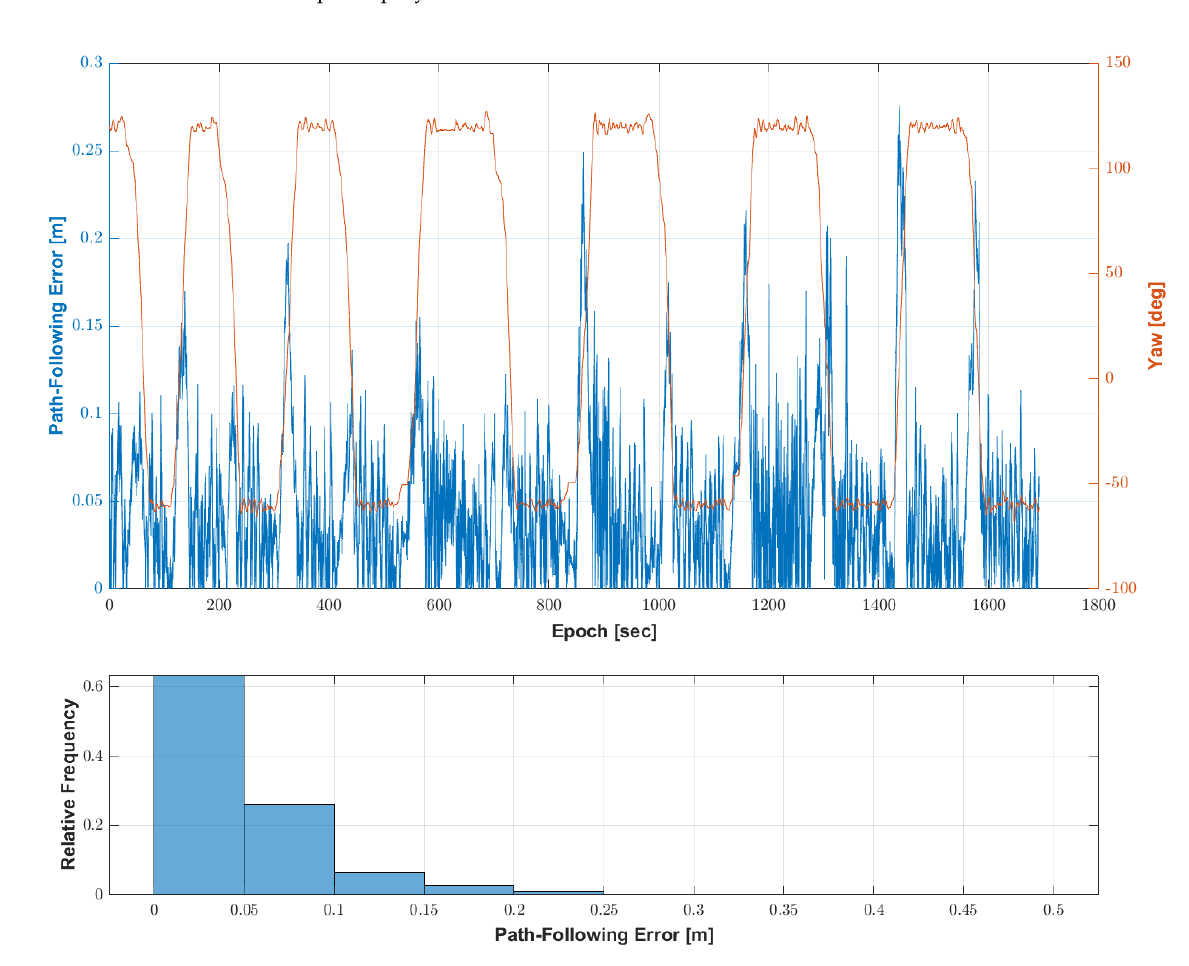
Figure 13. The path-following error during the second test of the autonomous driving-based spray- ing.